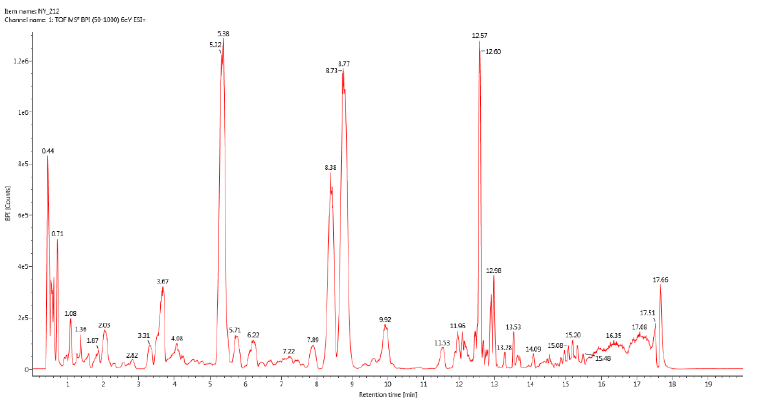
Figure 2. BPI total ion chromatogram of group 2.